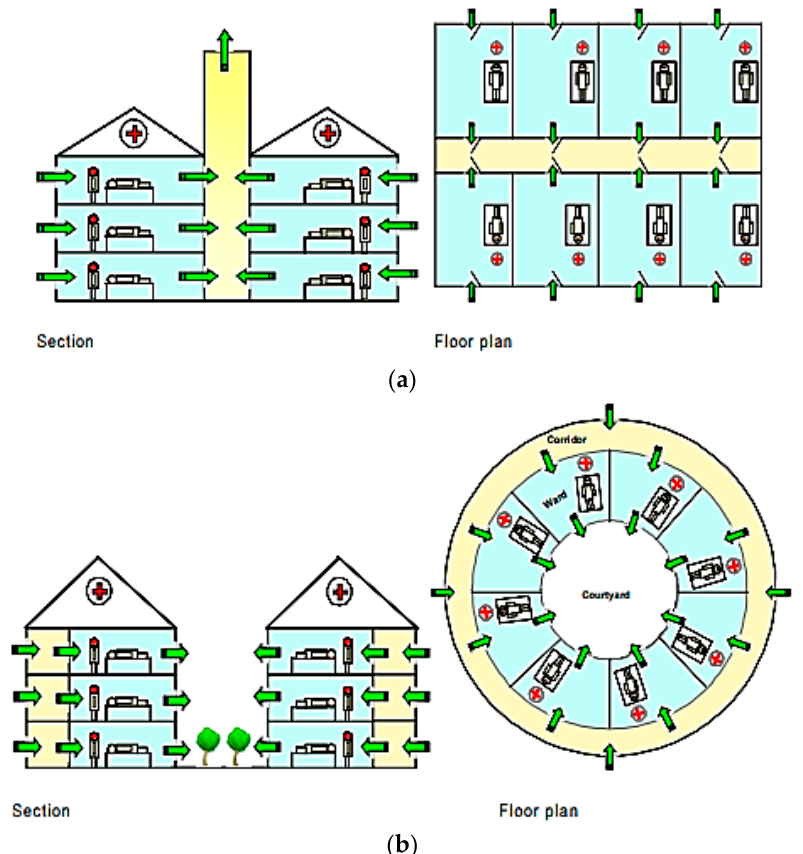
Figure 10. Natural ventilation and daylight for patient rooms: ( a ) a single-side corridor (rectangular design form of patient room) and ( b ) an inner corridor (circle design form of patient room) (adapted from [86]).